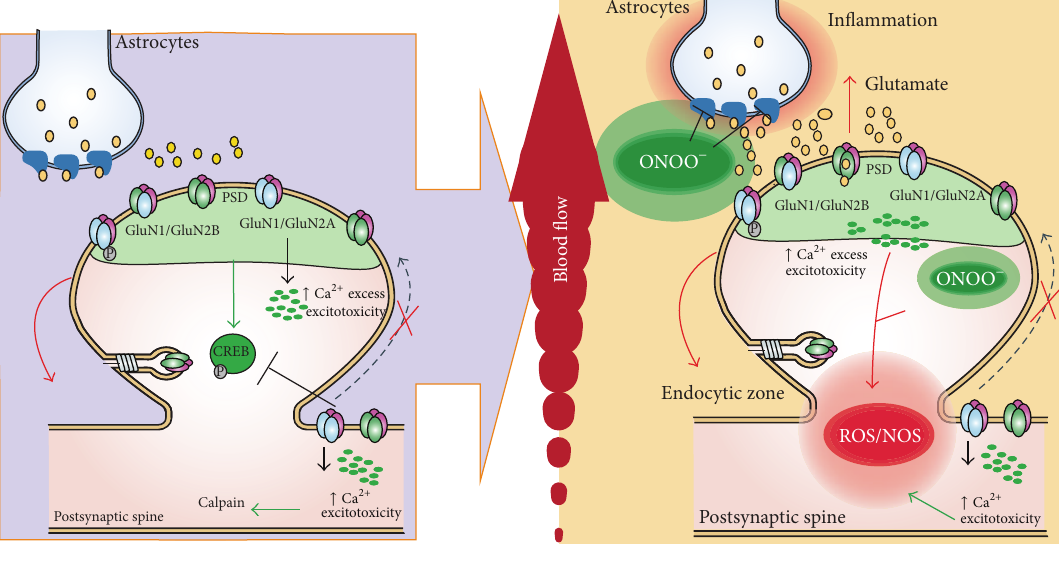
Figure 1: Implications of NMDAR in acute damage, ischemia/reperfusion. During ischemia, the overactivation of STEP induces the internalizationofNMDARs,principallyofGluN2Bsubunits,andtheactivationofextrasynapticNMDARtriggersanexcessofCa 2+ influxand excitotoxic events related to decreases in CREB activation and increases in calpain activity. During reperfusion, injury induces the generation of ROS and ONOO − . The increase of ONOO − alters the activity of glutamate transporter in astrocytes. The excess glutamate leads to the overactivation of